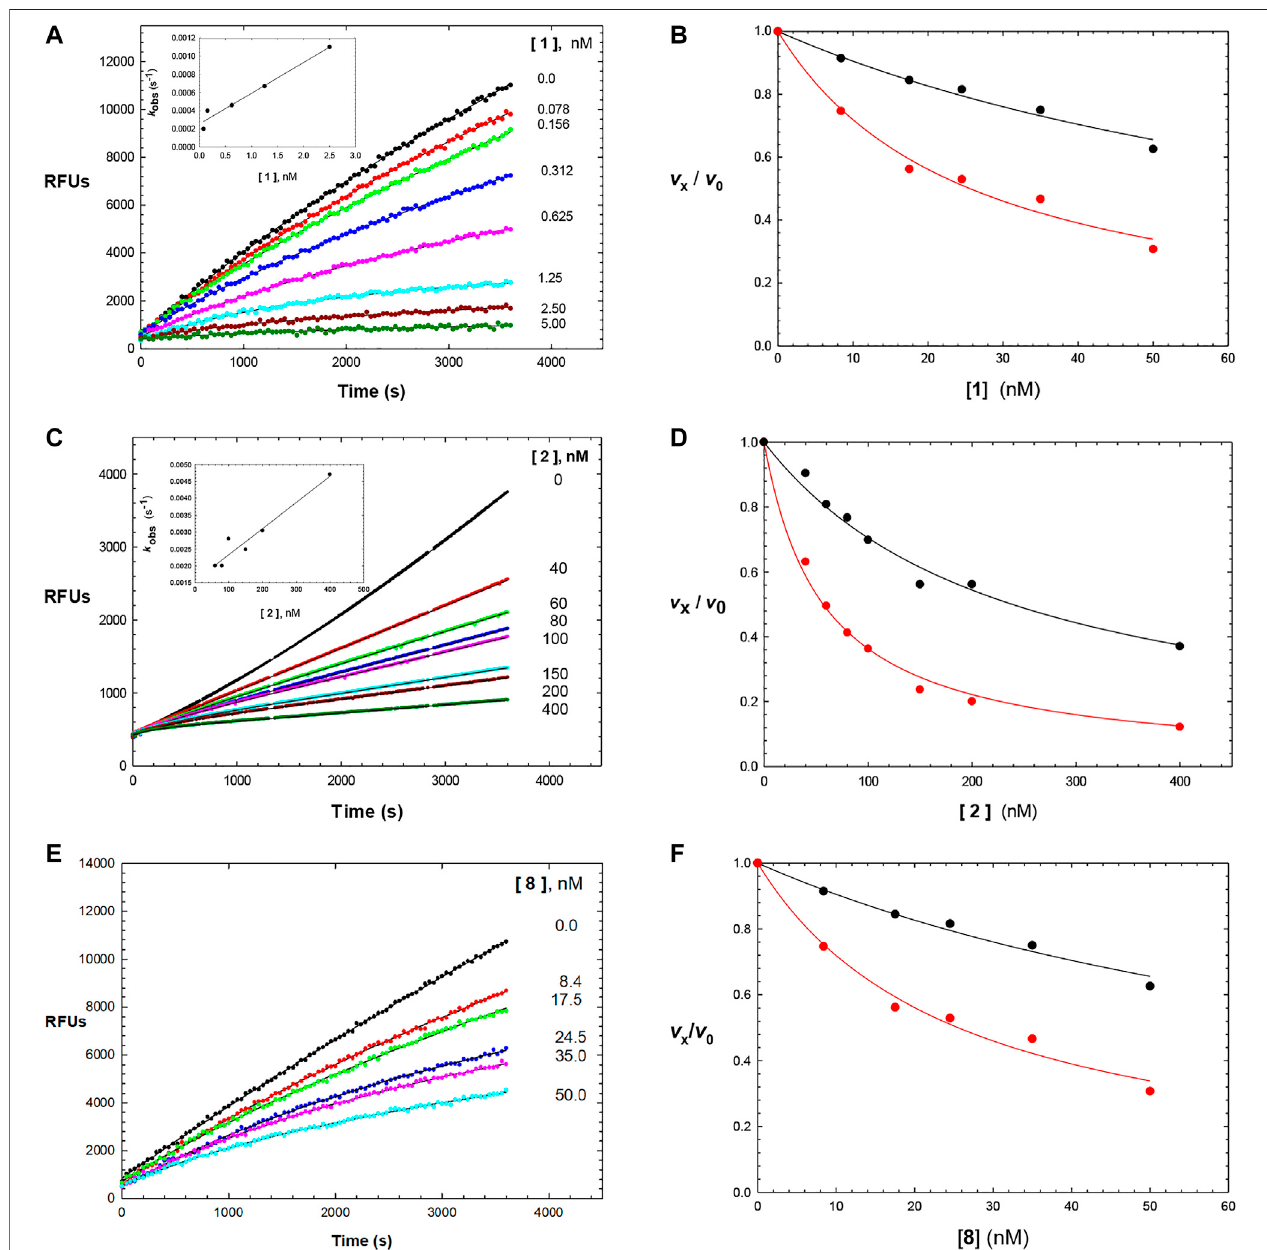
FIGURE2| Timecourses(0 – 3600 s)oftheinhibitionofhumancathepsinLbyCbz-Phe-Phe-CHO( 1 )( (A) ;0-5 nMofcompound 1 ),Cbz-Phe- o -Tyr-CHO( 2 )( (C) ;0 – 400 nM of compound 2 ), and NMe-Pip-Phe- o -Tyr-CHO ( 8 ) ( (E) ; 0 – 50 nM of compound 8 ). The measured RFUs (relative fl uorescence units) were obtained upon cleavage of the fl uorogenicpeptidesubstrateCbz-Phe-Arg-AMC(10 μ M; 3X itsapparentMichaelisconstantwithhumancathepsinL).Thelinesdrawnthroughtheexperimentalpointswerefrom theplottingofeach lineto Eq.1 ,andresultingvaluesof v i and v s werenormalized bydividingby v i and v s at[I]=0( v 0 ). toprovidevaluesof v i / v 0 and v s / v 0 ,whichwerethen replottedvs.eachconcentrationofinhibitoras v i / v 0 vs.[inhibitor](black)and v s / v 0 vs.[inhibitor](red)in (B , D , F) .Eachplotwas fi ttedtoversionsoftheCheng – Prusoffequation( Eq.4 for v i / v 0 , and Eq. 5 for v s / v 0 ), to provide, the apparent inhibition constants of K i and K i *, respectively. The insets in Figures 2A,C are replots of k obs vs. [ 1 ] and k obs vs. [ 2 ], from valuesof k obs obtainedfromeachtime-coursecurveforeachinhibitorfrom fi ttingto Eq.1 ,respectively.Thelinedrawnthroughtheinsetplotswerefrom fi ttingto Eq.3 ,resultingin valuesof k 3 /[ K i (1+[A]/ K a )]=(1.5±0.2)×10 − 4 nM − 1 s − 1 and k 4 =(2.6±0.5)×10 − 4 s − 1 (inhibitor 1 ),and k 3 / K i =(4±0.5)×10 − 6 nM − 1 s − 1 and k 4 =0.0016±0.0002 s − 1 (inhibitor 2 ). Fitting of v i / v 0 and v s / v 0 vs. [ 8 ] resulted in values of K i = and K i * which are found in Table 1 , along with all inhibition parameters.